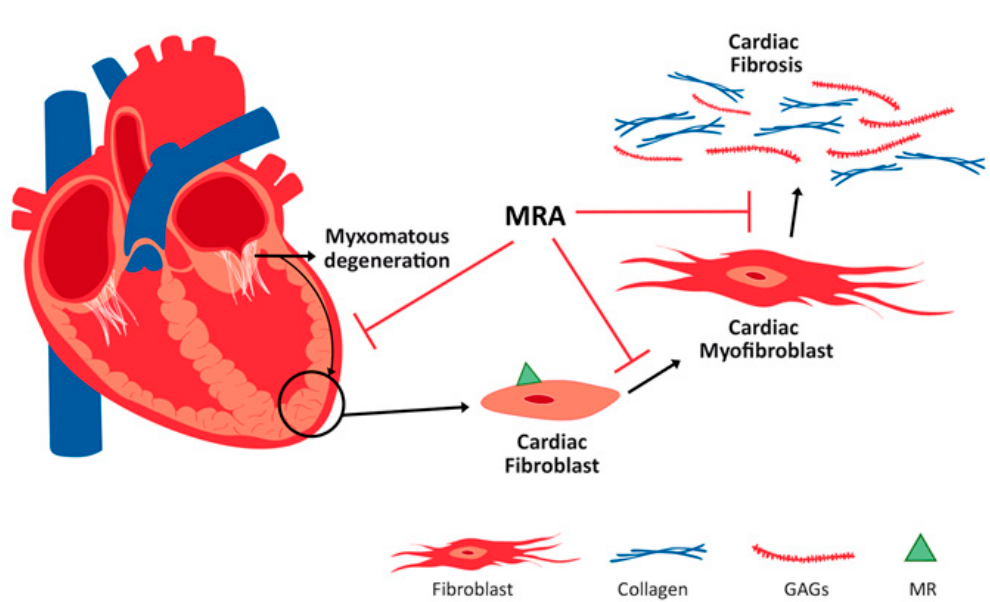
Figure 5. Refining the mineralocorticoid receptor antagonist (MRA) as a new pharmacological approach to treat myocardial fibrosis associated with myxomatous mitral valve disease.